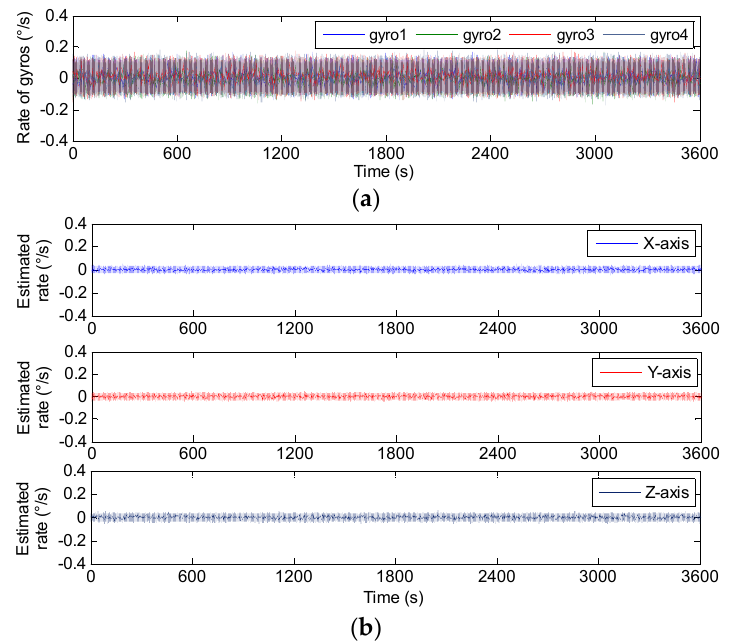
Figure 21. The static estimated results of 4-MIMU. ( a ) The outputs of gyros. ( b ) The estimated rate of